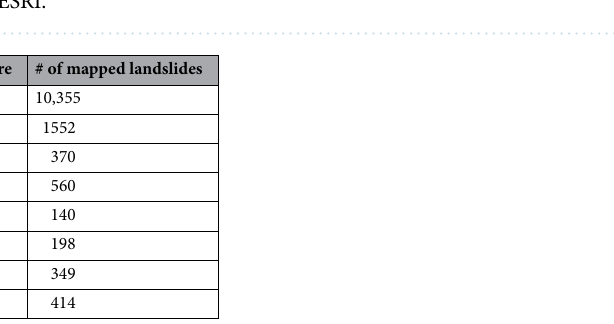
Figure 5. Multi-temporal landslide inventory of Rasuwa, Nepal from 2013 till 2019. The location, area (in m 2 ), and the year of the inventories are depicted above (see Table S1 in the Supplementary Materials for the landslide statistics indicating differences between the GI and the PI for each year in the testing windows). Shaded relief base map credits: World Shaded Relief-ESRI.